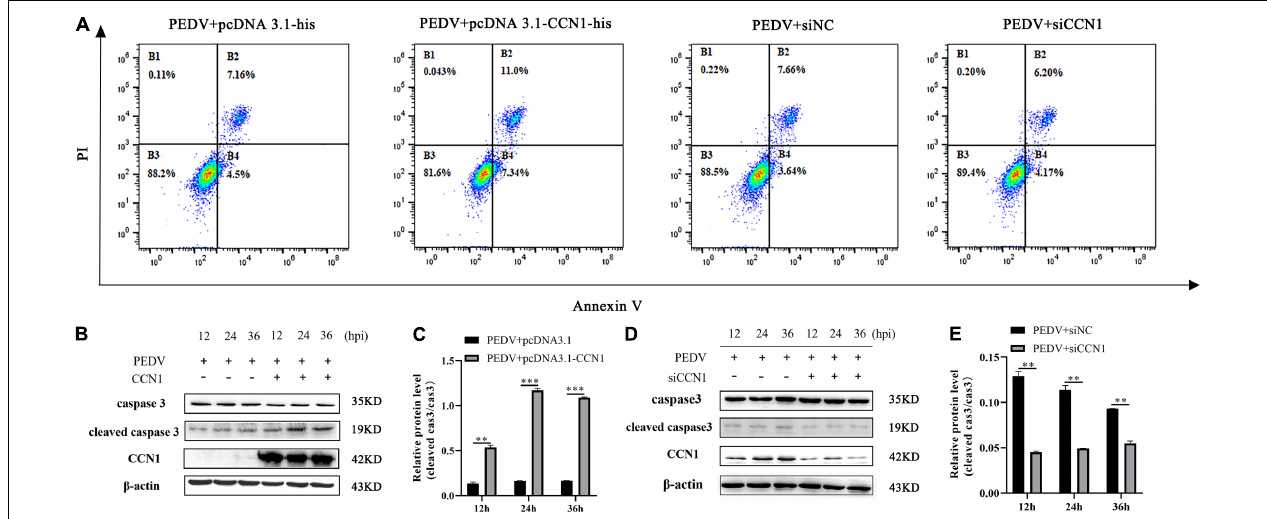
FIGURE 7 | Cell communication network factor 1 regulates PEDV-induced apoptosis in Marc-145 cells. (A) Marc-145 cells were transfected with pcDNA3.1-his, pcDNA3.1-CCN1-his, siNC, and siCCN1, stained with annexin V and PI, and apoptosis was detected by flow cytometry. (B) Marc-145 cells were transfected with pcDNA3.1-CCN1-his or pcDNA3.1-his vector for 36 h and infected with the PEDV. Cells were harvested at the indicated time, and Western blot was used to assess the expression of the caspase 3 and cleaved caspase 3. (C) Densitometric analysis of cleaved caspase 3 relative to caspase 3 using ImageJ. (D) Marc-145 cells were transfected with siNC or siCCN1 for 48 h and infected with the PEDV. Cells were harvested at the indicated time, and Western blot was used to assess the expression of the caspase 3 and cleaved caspase 3. (E) Densitometric analysis of cleaved caspase 3 relative to caspase 3 using ImageJ. The data were performed from three independent experiments. The differences were evaluated using Student’s t -test, and significance differences were denoted by ∗∗ p < 0.01, ∗∗∗ p <